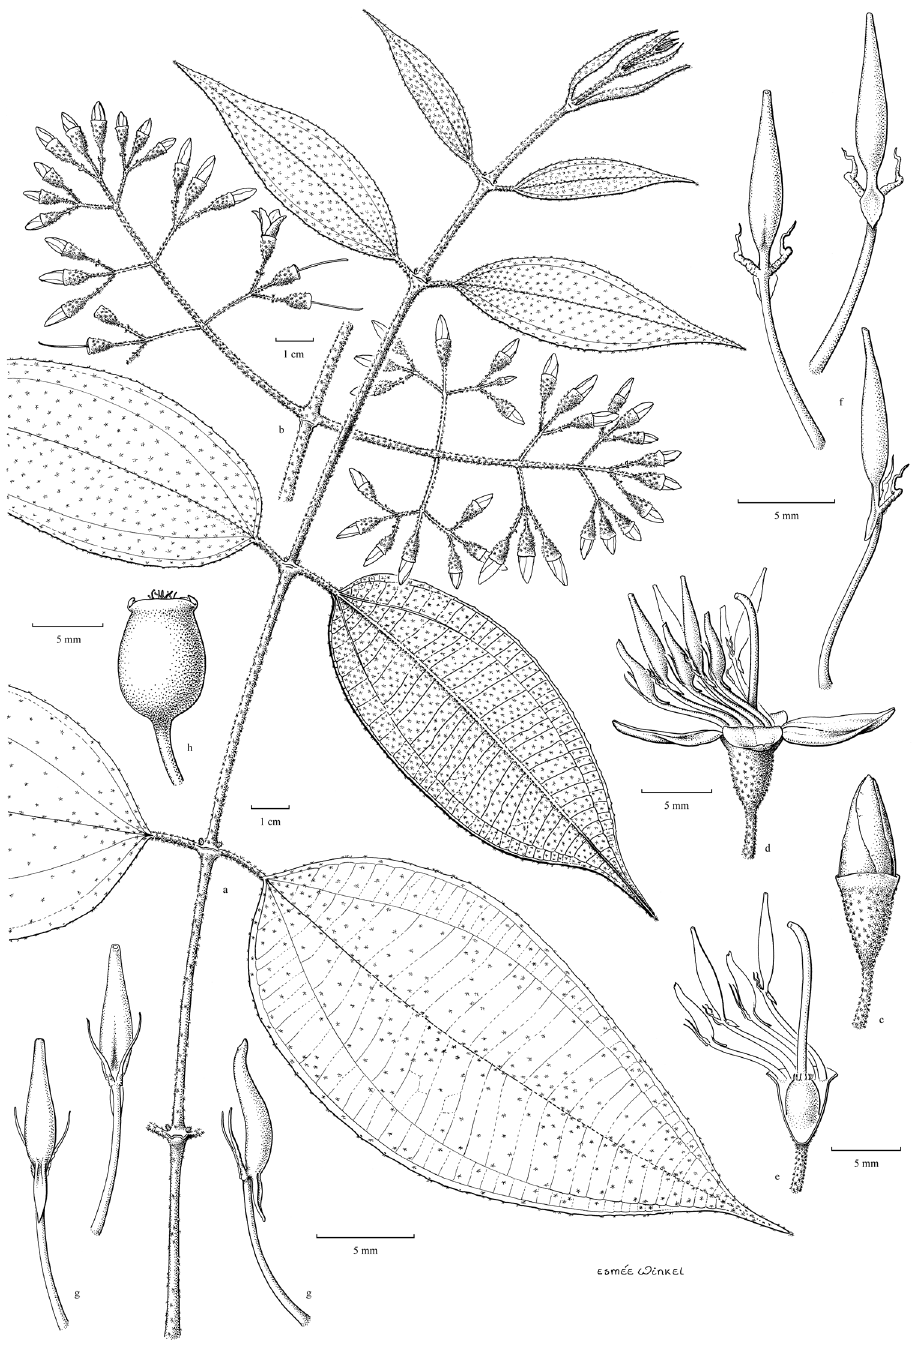
Figure 25. Dissochaeta rectandra a habit b inflorescence c hypanthium d open flower e ovary f alterni- petalous stamens g oppositipetalous stamens h fruit. [drawn from Carrick 1606